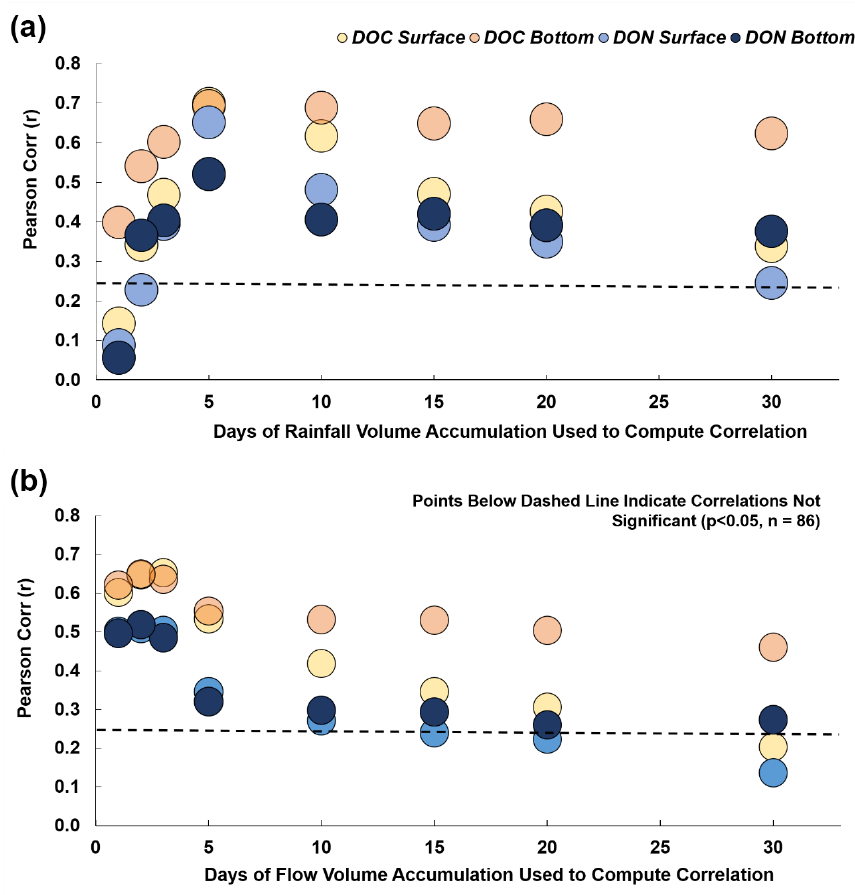
Figure 3. Pearson correlation coefficients ( r ) ( n = 86) between dissolved organic C and dissolved organic N concentrations measured at the Gordon River mouth and (a) accumulated rainfall and (b) accumulated flow at the Gordon River mouth. Note that all correlations are statistically significant ( p< 0 . 05) except those circles whose centres are below the dashed line. The x axis represents the number of days over which the volume of rain or estimated flow is summed and used to compute the correlations between DOC and DON. For instance, 5d rainfall volume is equal to the rainfall volume measured at Strathgordon gauge over the 5d prior to water sampling at station